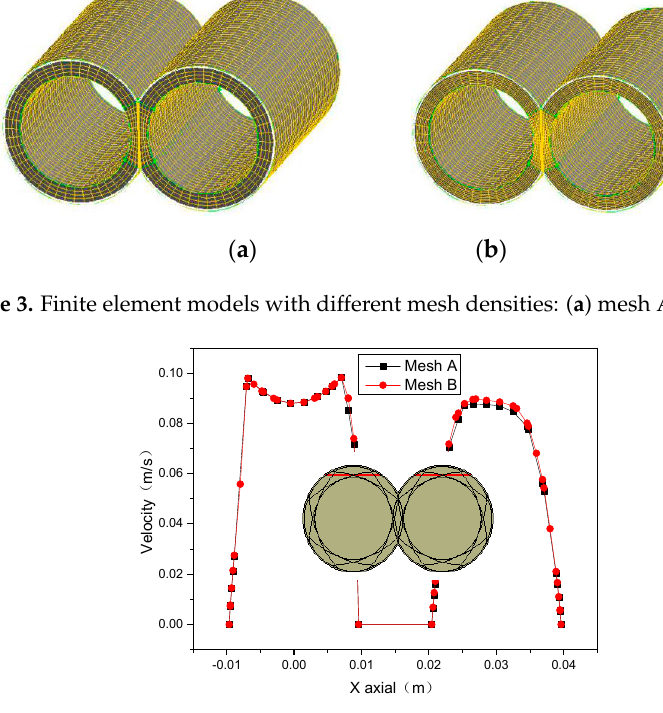
Figure 4. Velocity magnitude profiles and position of line in the TSE.